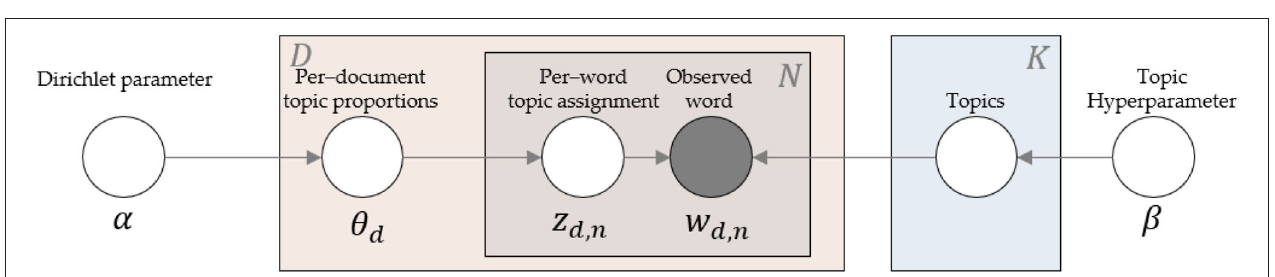
FIGURE 3 | Intuition behind